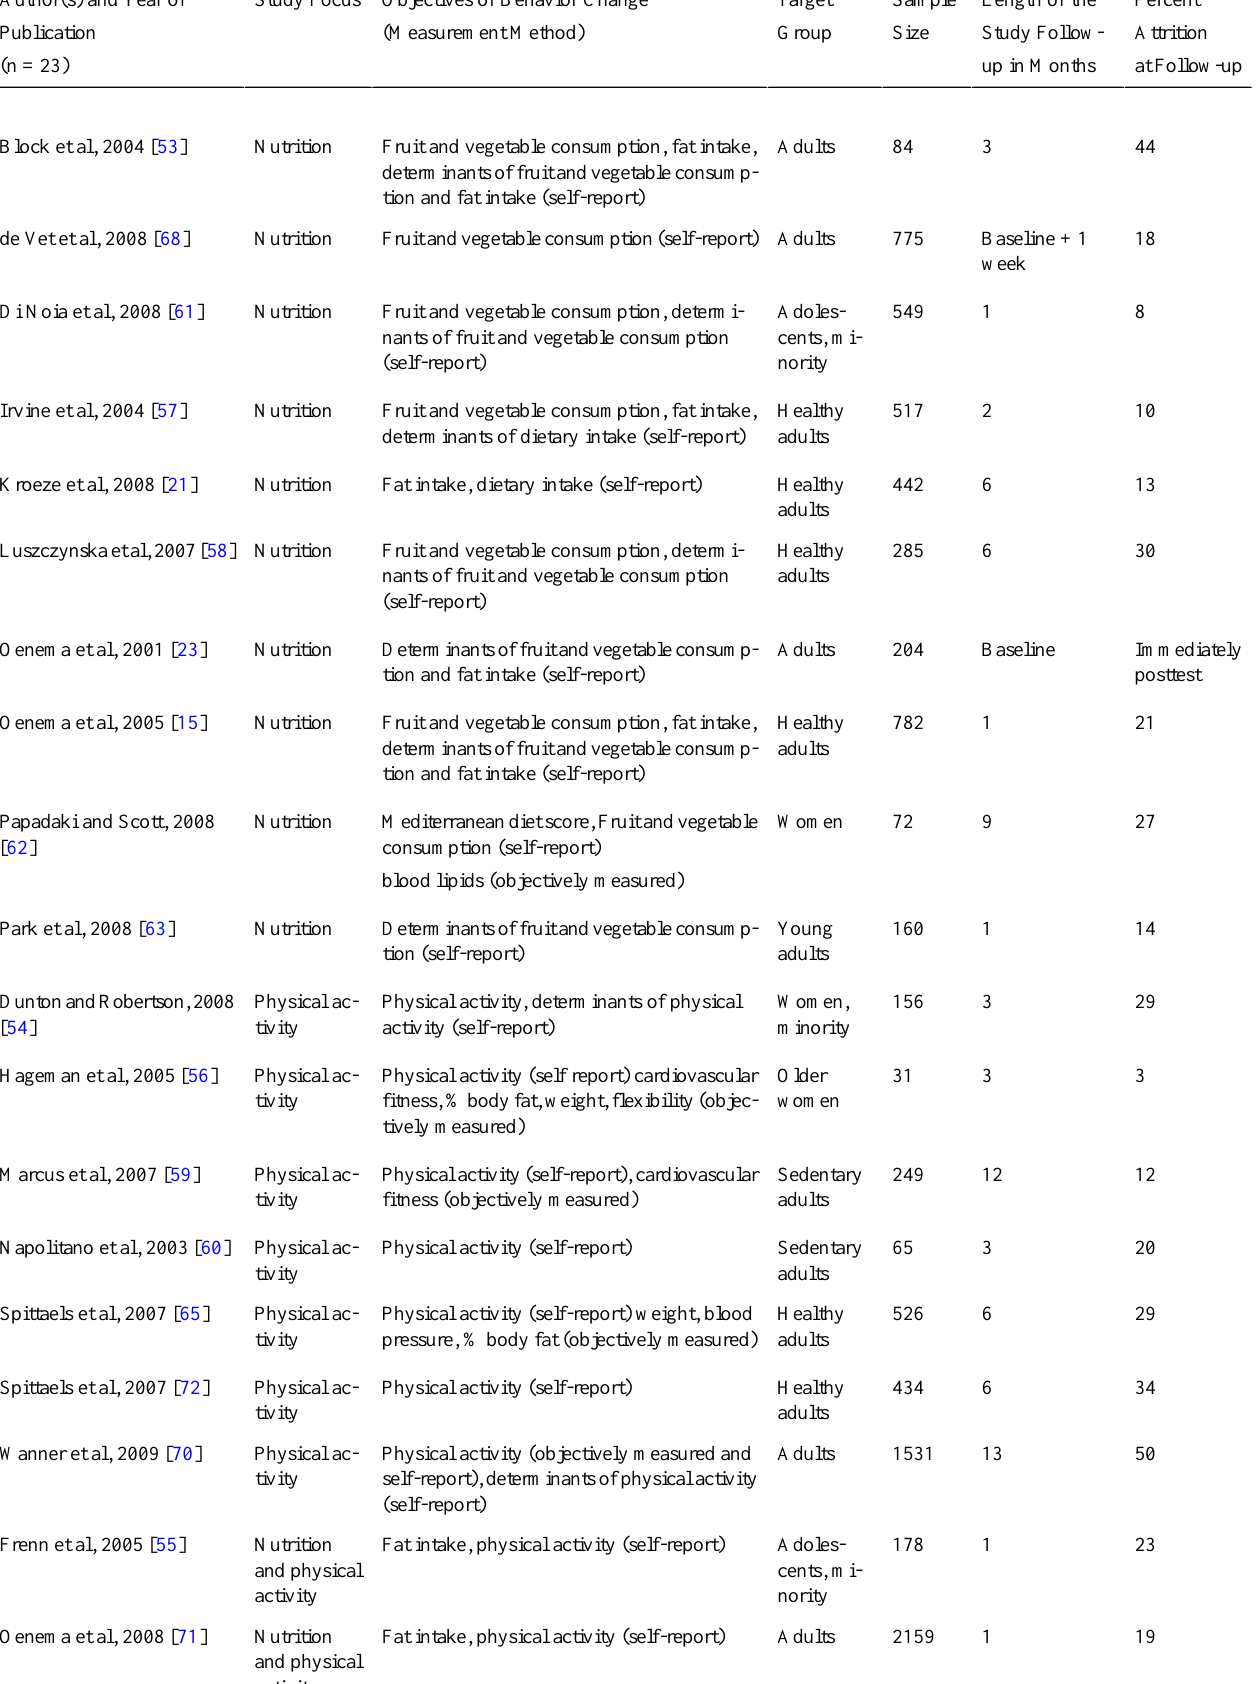
Table 1. Objectives of behavior change, target groups, sample sizes, lengths of follow-up periods, and attrition rates of the selected intervention